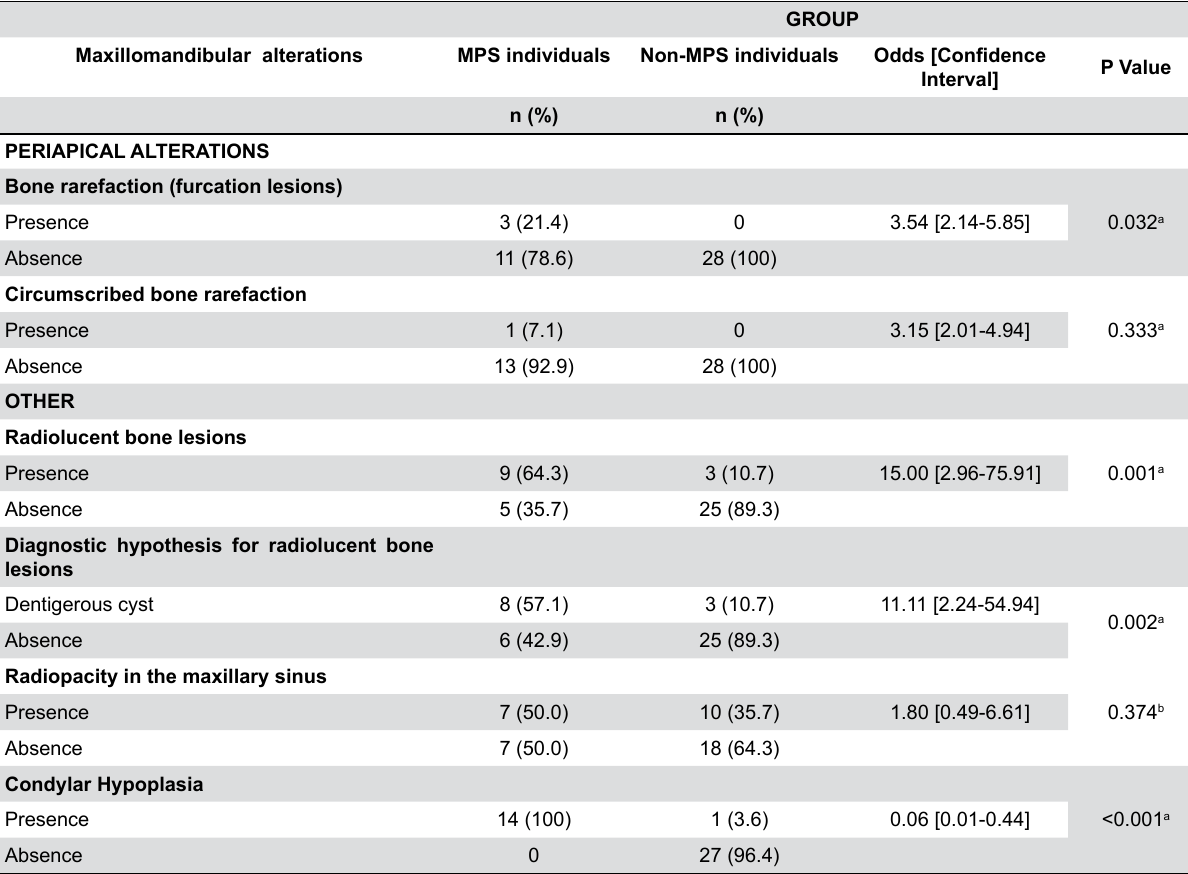
Dental and maxillomandibular incidental findings in panoramic radiography among individuals with mucopolysaccharidosis: a cross-sectional Table 2- Comparative radiographic analysis of the presence of maxillomandibular alterations between MPS and non-MPS individuals (N=42)